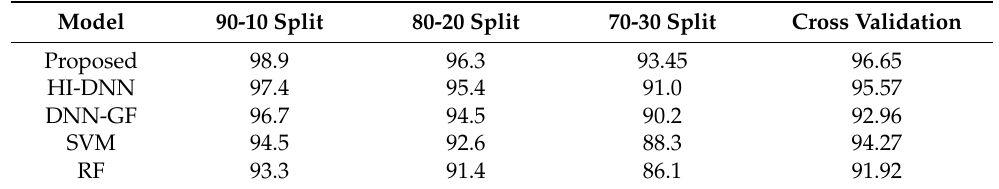
Table 6. Analysis for Cross-Validation.